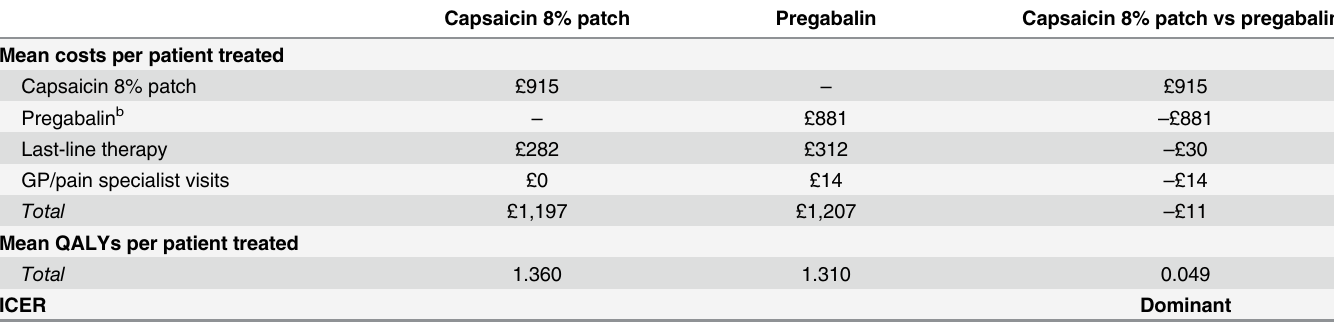
Table 3. Base-case analysis (2-year time